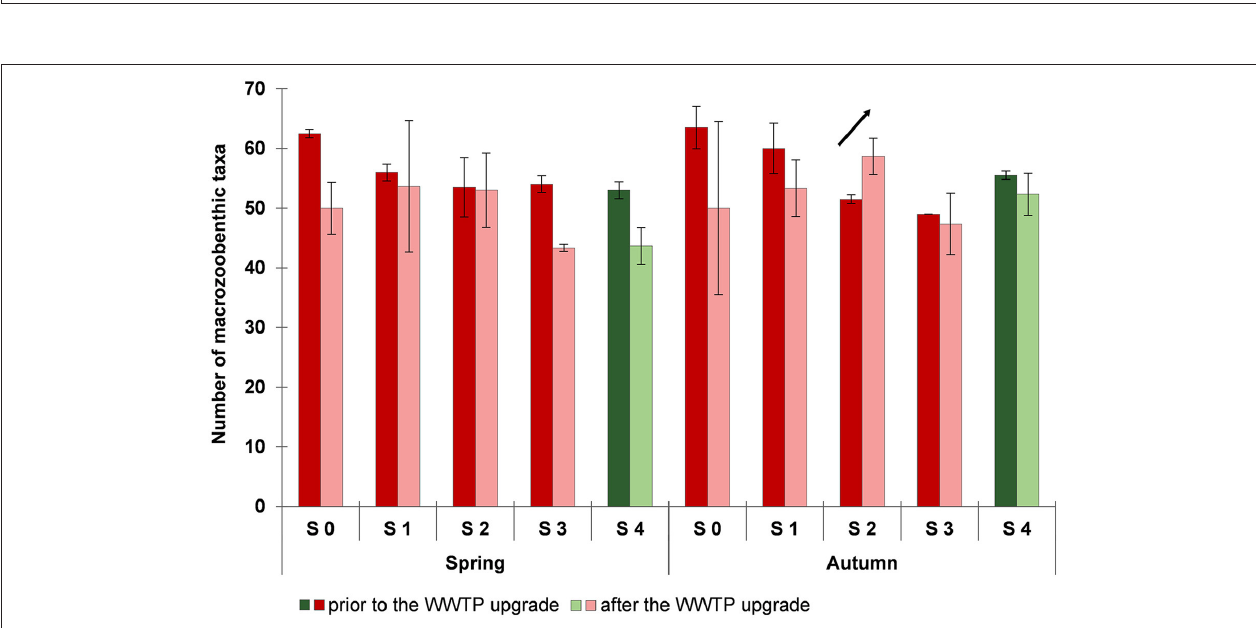
FIGURE 5 | Number of macrozoobenthic taxa in spring and autumn prior to (2012 and 2013, dark colors) and after (2014, 2015, and 2016; light colors) the wastewater treatment plant (WWTP) upgrade. Data are shown as arithmetic means and standard deviations. Data for the sampling sites at the Schussen river are shown in red colors: S 0 upstream of the WWTP and upstream of the stormwater overflow basin (SOB) Mariatal, S 1 upstream of the WWTP and downstream of the SOB, S 2 directly downstream of the WWTP, S 3 15km downstream of the WWTP; data for the sampling site S 4 at the Argen river are shown in green colors.